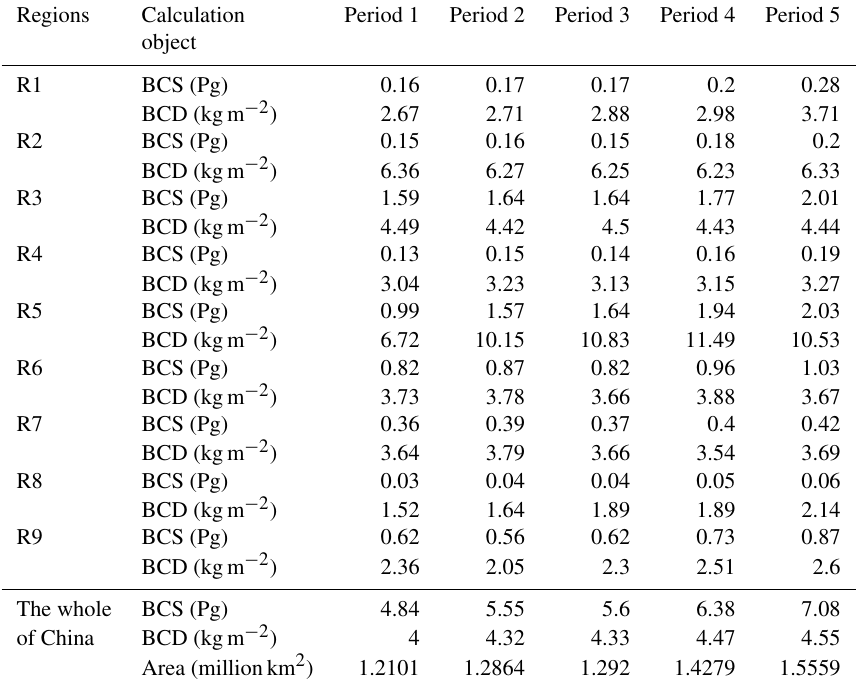
Table 4. Biomass carbon stocks and biomass carbon densities estimated by